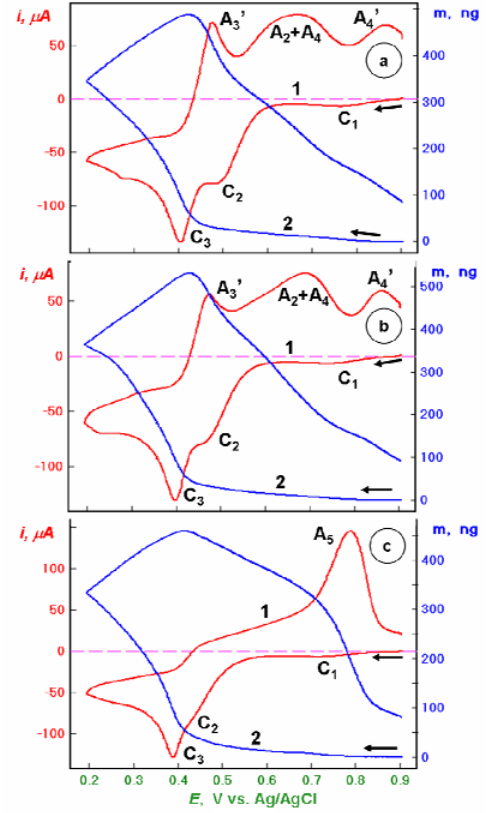
Figure 2. Linear potential scan voltammetric (1) and nanogravimetric (2) characteristics of piezosensors: (a) bare Au, (b) Au/CA, and (c) Au/CA-GSH, recorded in 0.1 M NaClO + 1.5 mM Hg(ClO ) solution, in the potential range from E = +0.9 to +0.2 V mM HClO 4 4 2 vs. Ag/AgCl, at a scan rate v = 50